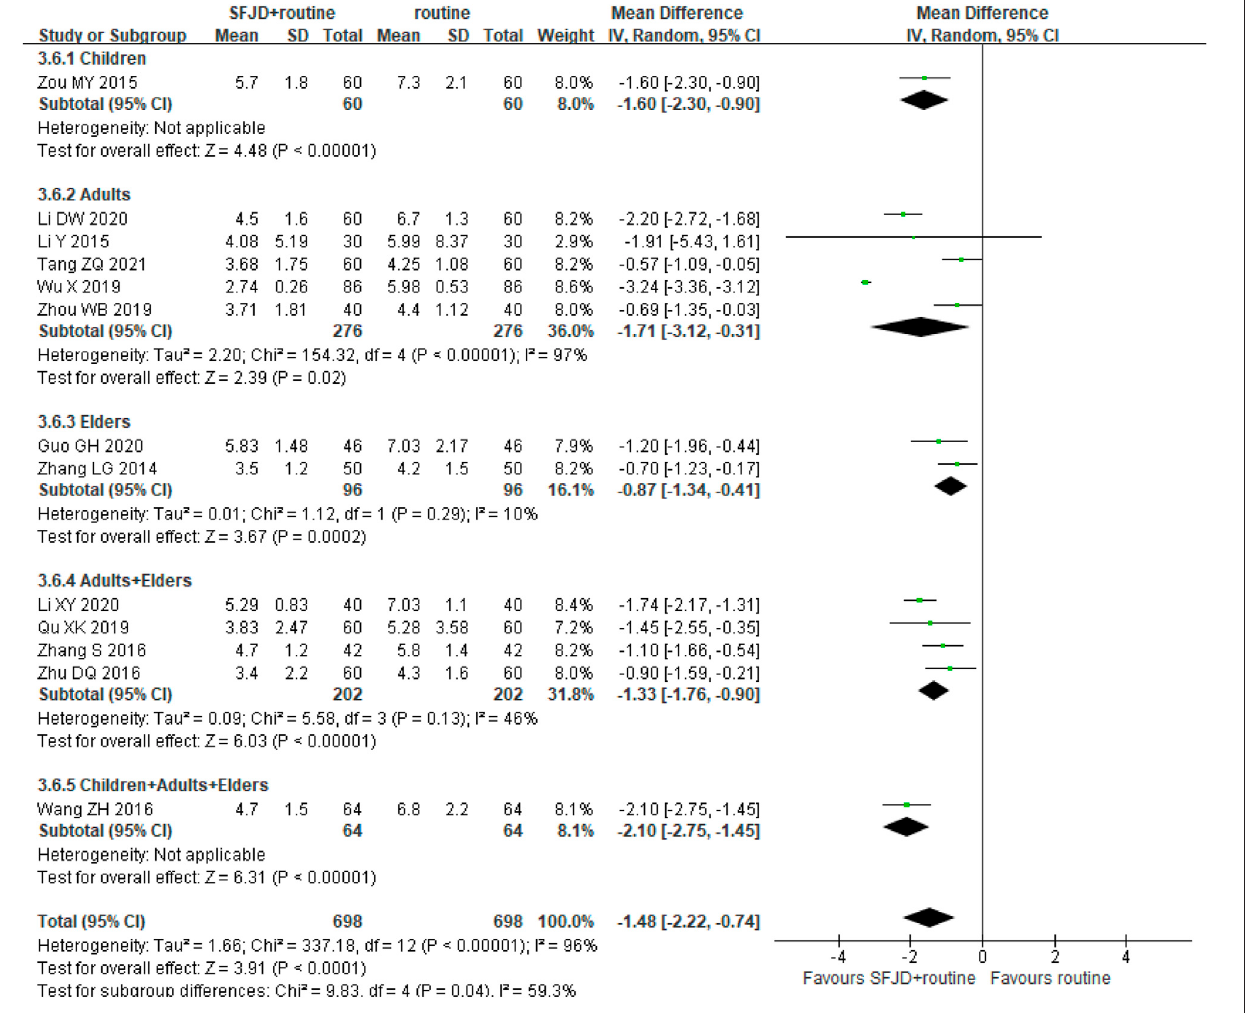
Frontiers in Pharmacology |